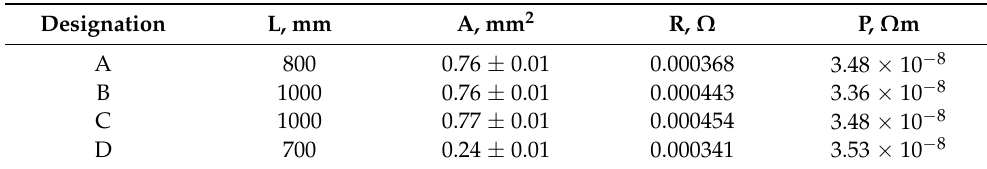
Table 3. Speci fi c electrical resistivity of investigated grain re fi ners. Table 3. Specific electrical resistivity of investigated grain